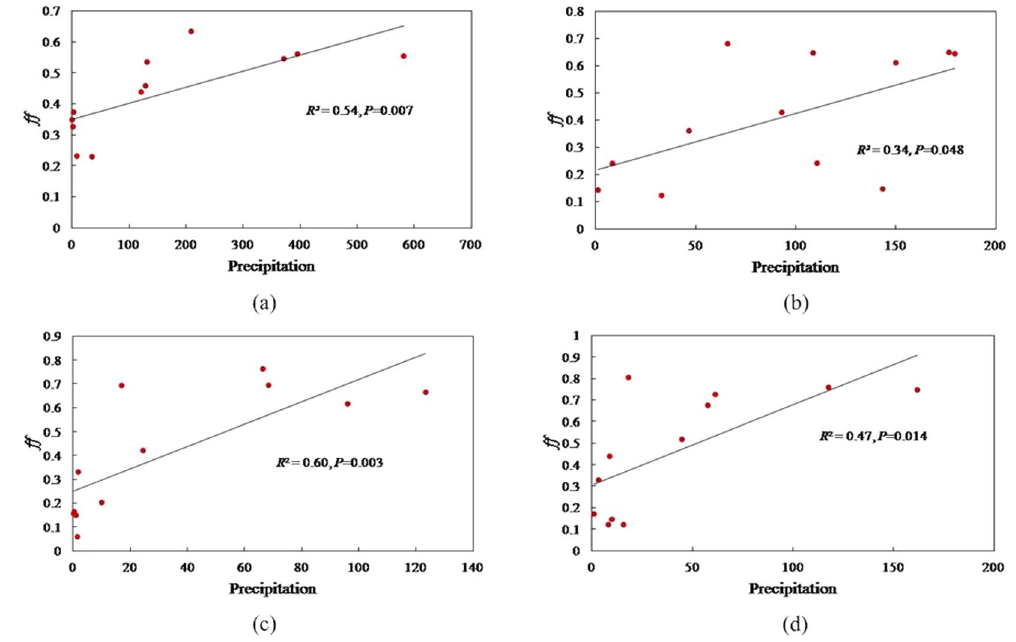
Figure 6. The relationships between precipitation and the fugacity fraction (ff) for PCB28 in the latitudinal direction from south to north with around four cities, ( a ) Guangzhou, ( b ) Wuhan, ( c ) Beijing, and ( d )